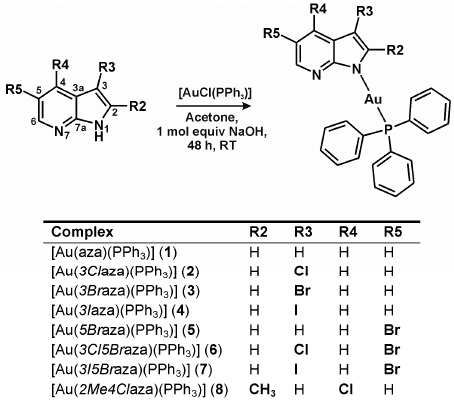
Figure 1. Synthetic pathway for the preparation of [Au( n aza)(PPh 3 )] ( 1 – 8 ), the structural formulas